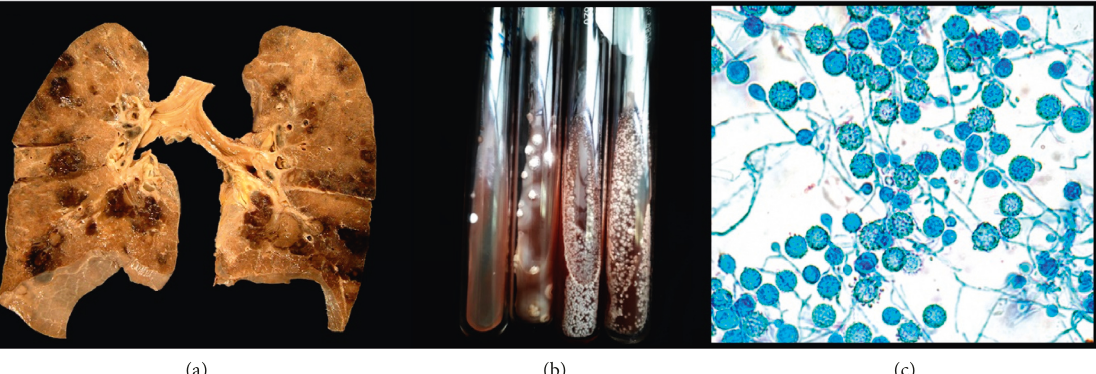
Figure 2: (a) Multiple nodular, hemorrhagic, and cavitated lesions scattered throughout the lung parenchyma. (b) Sabouraud’s dextrose agar medium observing white, downy-looking colonies. (c) Direct examination with lactophenol cotton blue, in which thin, septate, hyaline hyphae with round, spiculated macroconidia were observed in a 40X